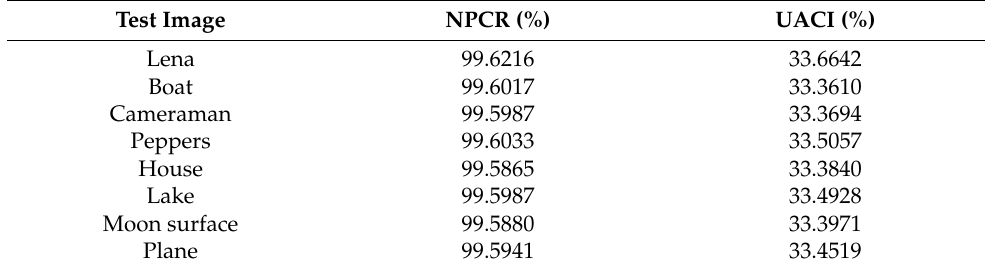
Table 6. The NPCR and UACI values of encrypted images.